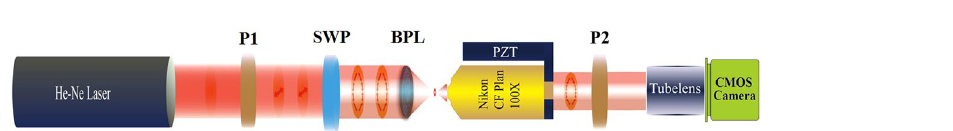
Figure 5. The experimental microscope setup. The laser beam from a He-Ne Laser passes through linear polarizer P1, and is converted to an azimuthally polarized Laguerre-Gaussian wave by S-waveplate SWP. Then, the wave is converted to an optical hollow needle by the super-oscillatory binary-phase lens BPL. A microscope system composed of a Nikon CF plan 100 × objective lens with NA = 0.95, open-loop nano-positioner PZT, tube lens, and CMOS camera is used to obtain the intensity image of the optical field generated by the BPL. The linear polarizer P2 is used only to verify the polarization of the resulting optical hollow needle, and removed